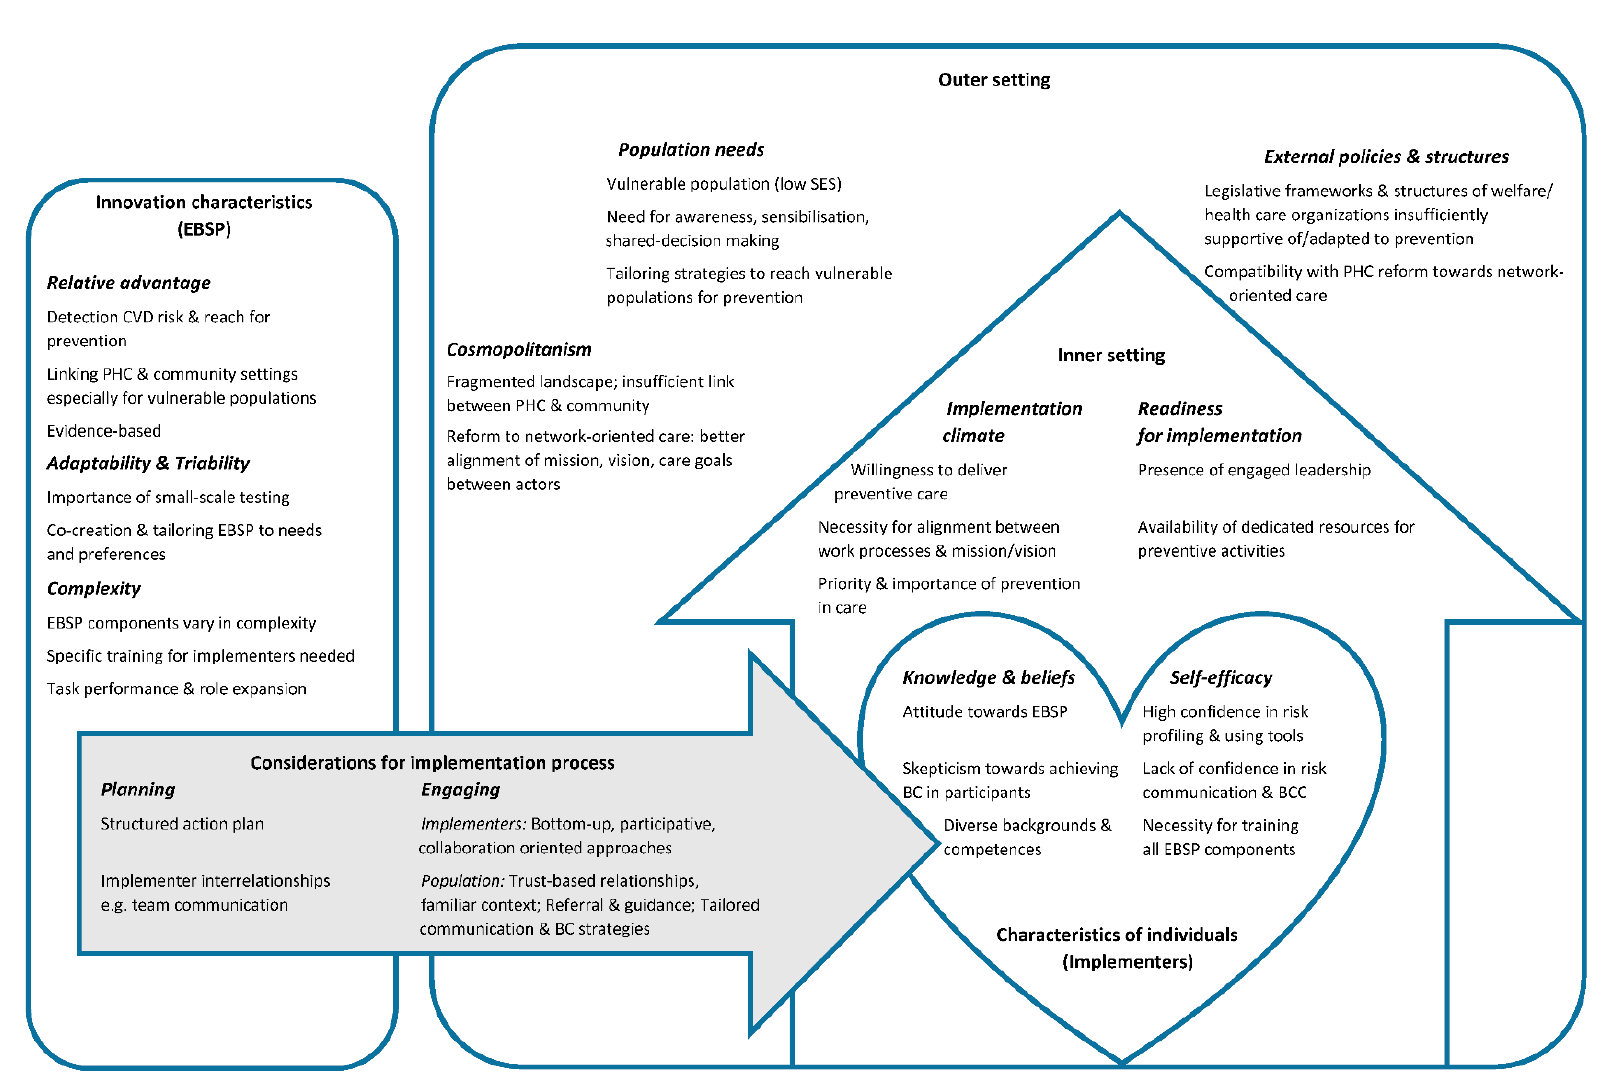
Figure 1. Summary of main results structured into CFIR domains and relevant constructs.